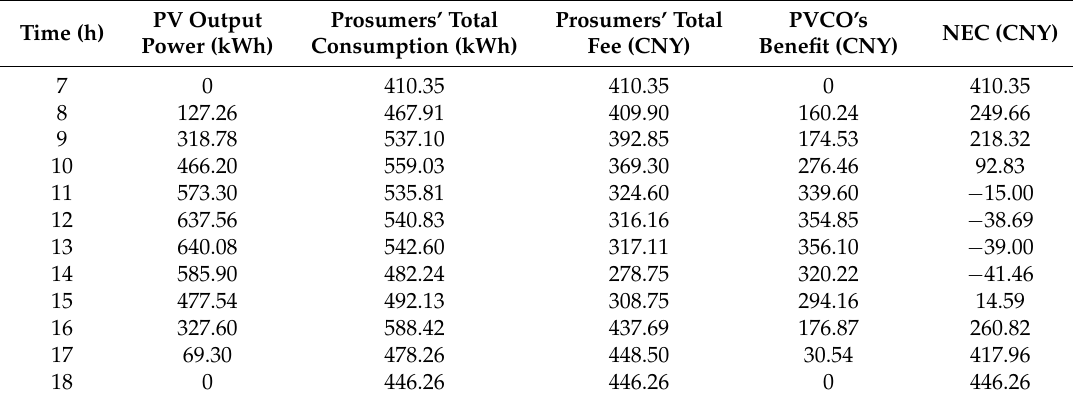
Table 1. Incomes and expenditures of participant entities in the